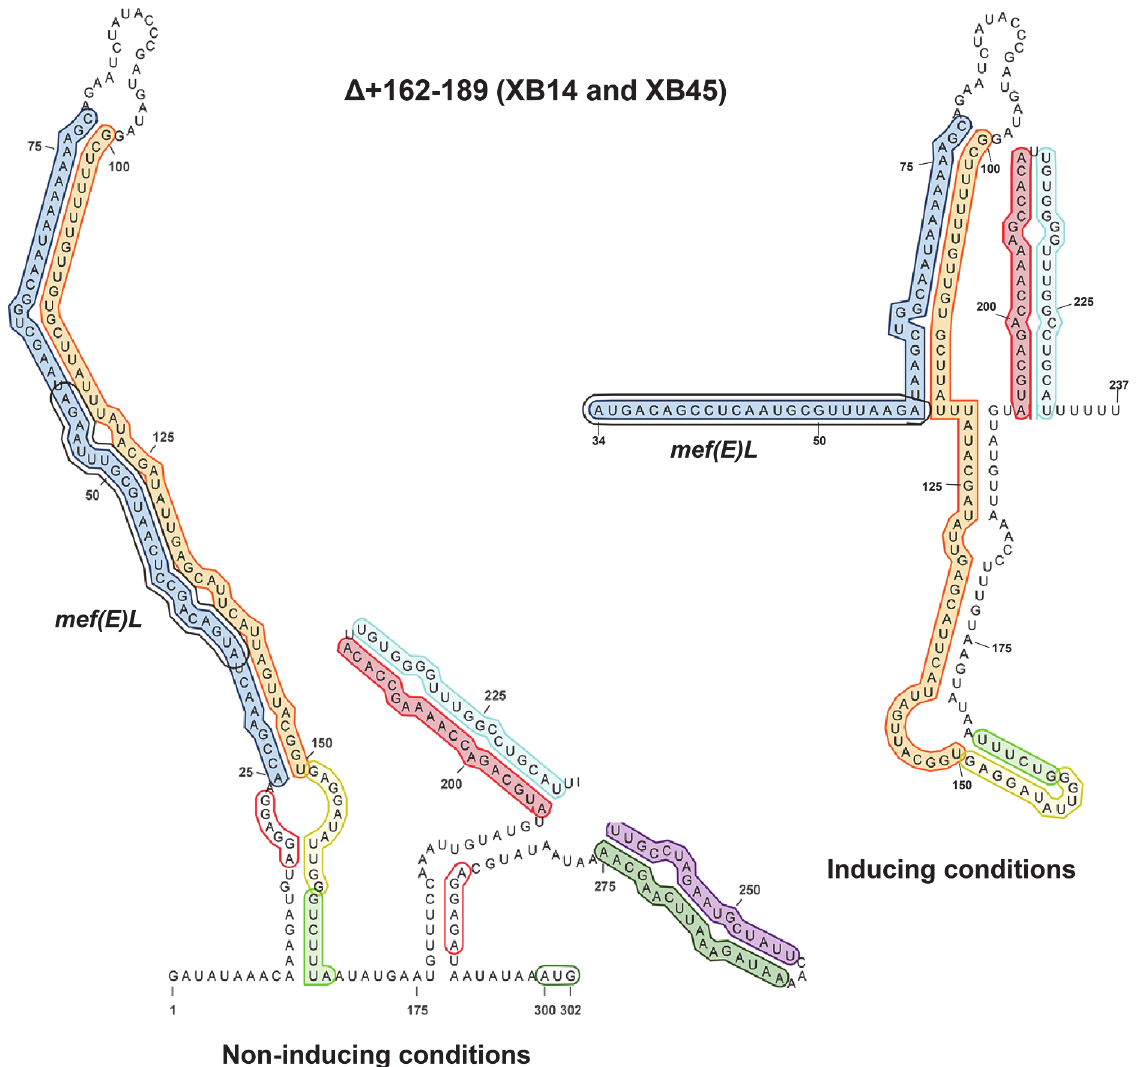
Fig 6. Stem-loop R3/R4 is required for mef(E)/mel expression. The predicted secondary structures of the Δ +162 – 189 mef(E)/mel regulatory region in (a) non-inducing and (b) inducing conditions. Disruption of R3/R4 by mutation was predicted to not disrupt the R5/R6 transcriptional terminator in inducing or non-inducing conditions, indicating that mutants with the Δ +162 – 189 deletion were uninducible. Annotations are consistent with those described in the Fig. 1C legend. Inducing conditions include growth with exposure to erythromycin at a concentration equal to 10 -1 the erythromycin